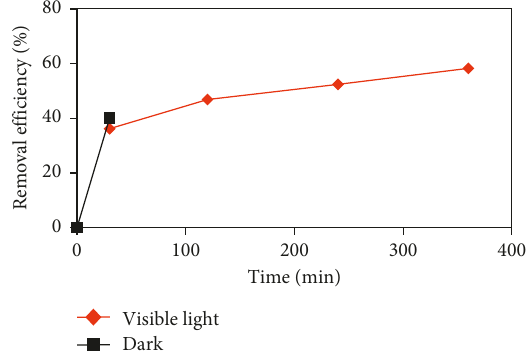
2 /Bent-Fe (a) and Langmuir model (b).